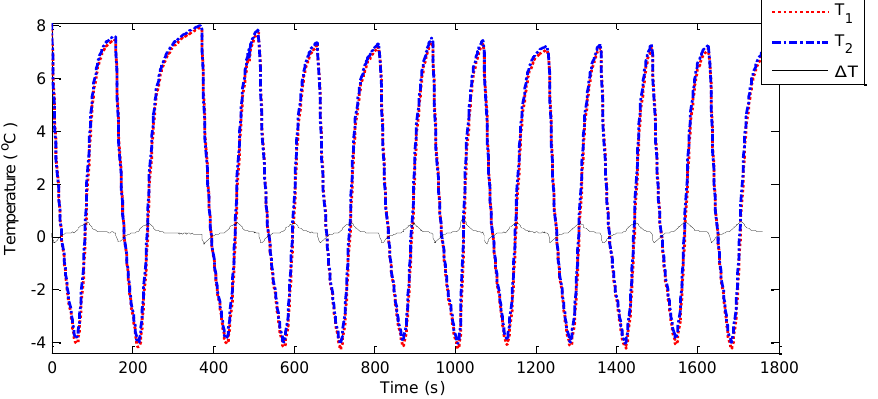
Figure 5. The measured temperature of the dual quartz crystal microbalance (DQCM).